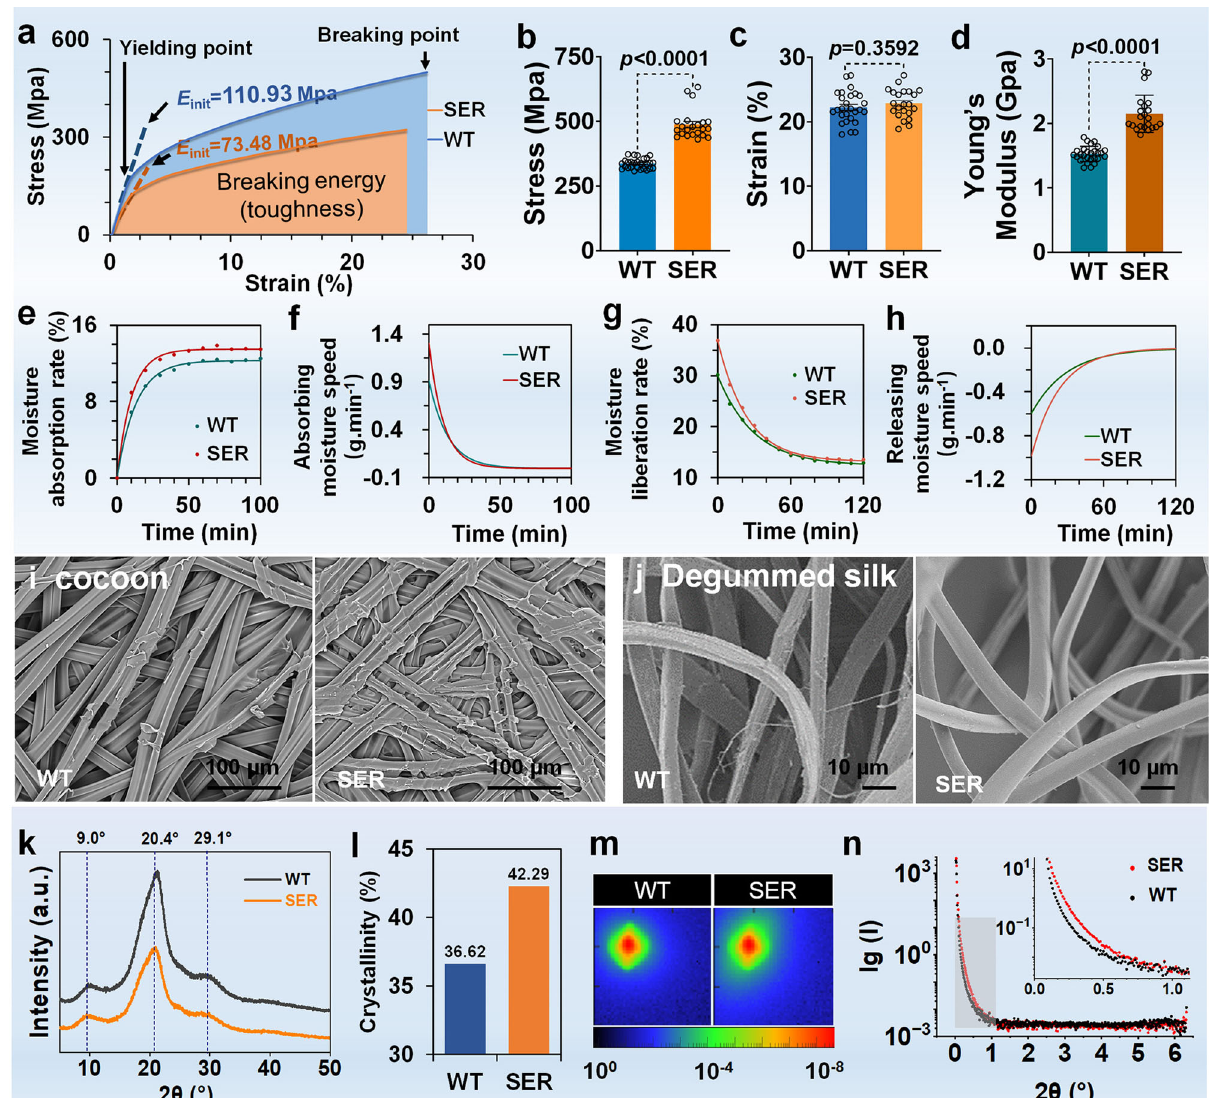
Fig. 3 | TheSER3protein secreted by thePSG improves the physicalproperties of silk fi bers. a – d Fiber mechanical properties. Reeling 20/22 dtex raw silk from cocoons (20 cocoons of WT or SER: one sample was taken every 3 – 4 meters between 100 – 200m to determine the mechanical properties. n =22 cocoons in SERandn=27cocoonsinWT. a Stressandstraincurve. b Stresslevel. c Modulusof elasticity. d Young ’ s modulus. Data were presented as mean±SEM, and the unpaired ttest analysiswas usedin( b-d ). e – h Moistureabsorption and desorption performance. The mono fi lament extracted from cocoons was boiled with 0.2% sodiumcarbonatefor30mintoremovetheoutersericinproteinandobtaintextile fi broin fi ber. e Moisture absorption rate (constant temperature and humidity conditions: 20°C±2°C, R.H. 65%±3%). f Moisture absorption speed. The fi